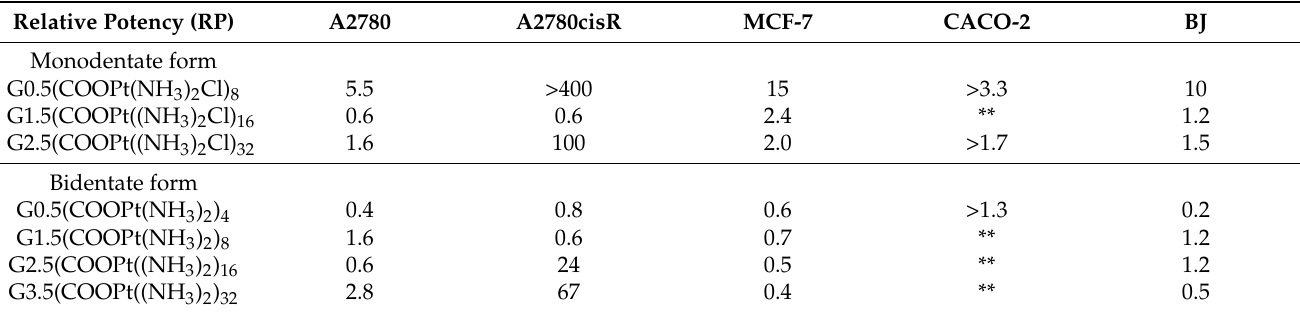
Table 4. Relative potency (RP) of the metallodendrimers